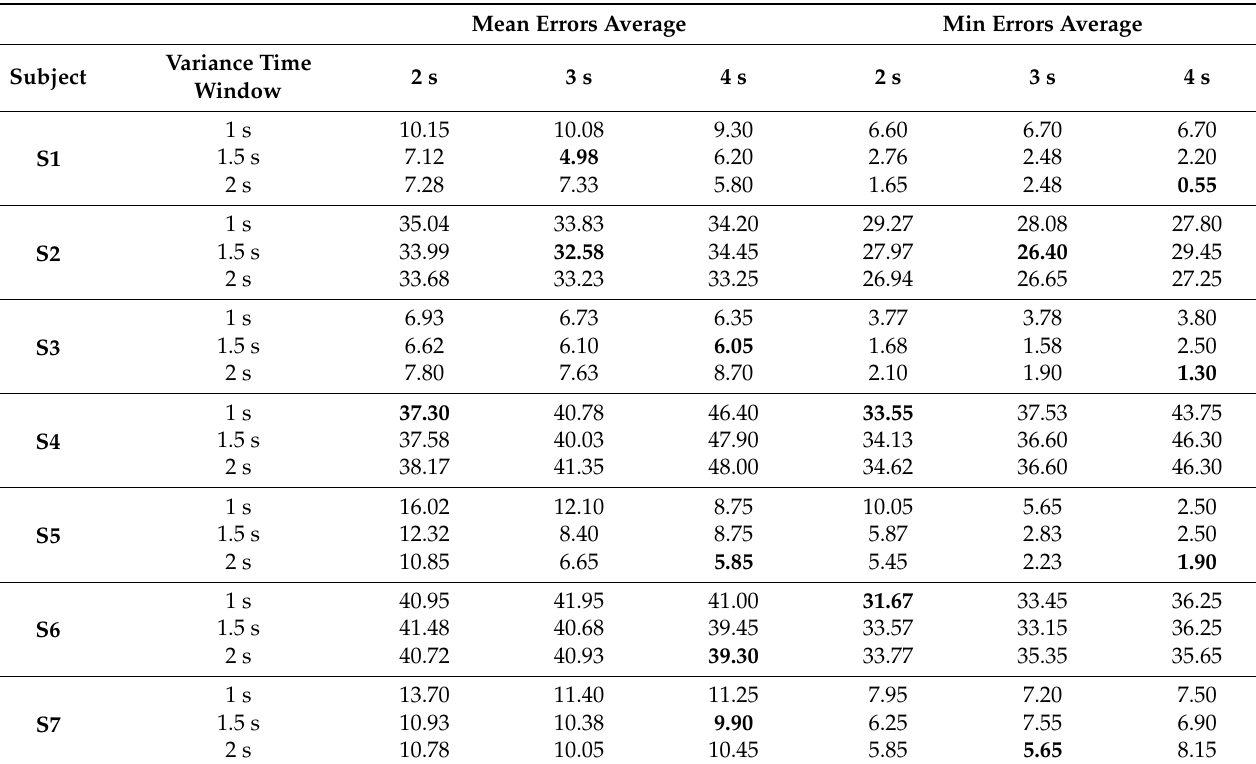
Table 1. Error-values vs. variance time windows for all CSP.